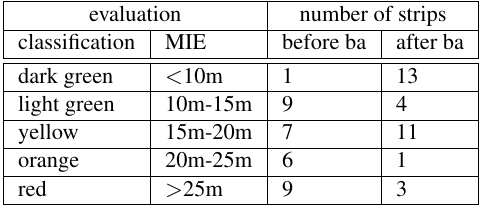
Table 1: Evaluation of the single strip bundle adjustment results